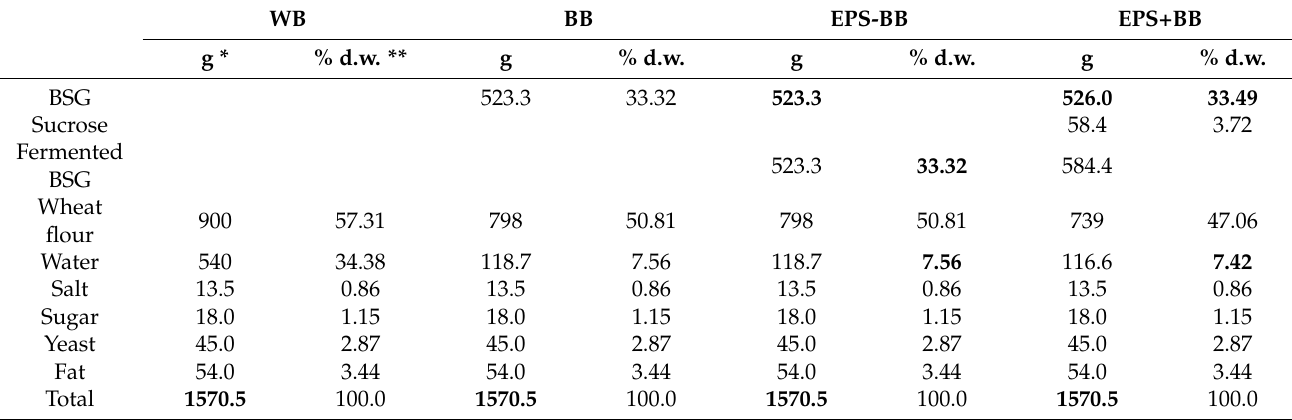
Table 1. Recipes for fermented BSG and BSG bread